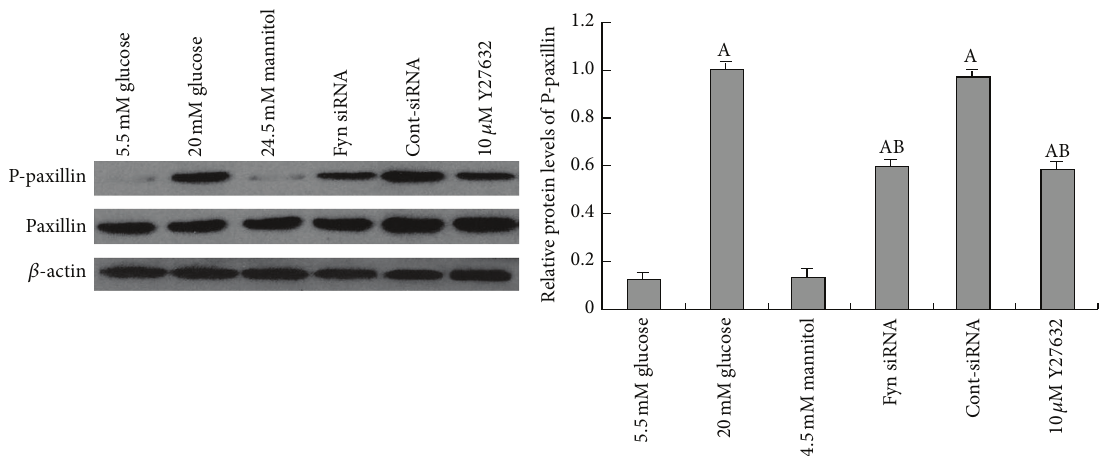
Figure 8: Western blotting analysis of the phosphorylation levels of paxillin in podocytes. The phosphorylation of paxillin (PY31) was significantly increased after a 48-hour incubation with 30 mM glucose (lane 2) compared with cells incubated with 5.5 mM glucose (lane 1), and no alterations in total paxillin expression were noted. Transfection with Fyn siRNA for 24 hours (lane 4) or pretreatment with 10 𝜇 M Y27632 for 30 minutes (lane 6) partially decreased high glucose-induced paxillin phosphorylation. Control podocytes were treated with Cont-siRNA (lane 5) or 5.5 mM glucose plus 24.5 mM mannitol (lane 3). Values denote the mean ± SD; A 𝑃 < 0.05 versus 5.5 mM glucose and B 𝑃 < 0.05 versus 30 mM glucose.